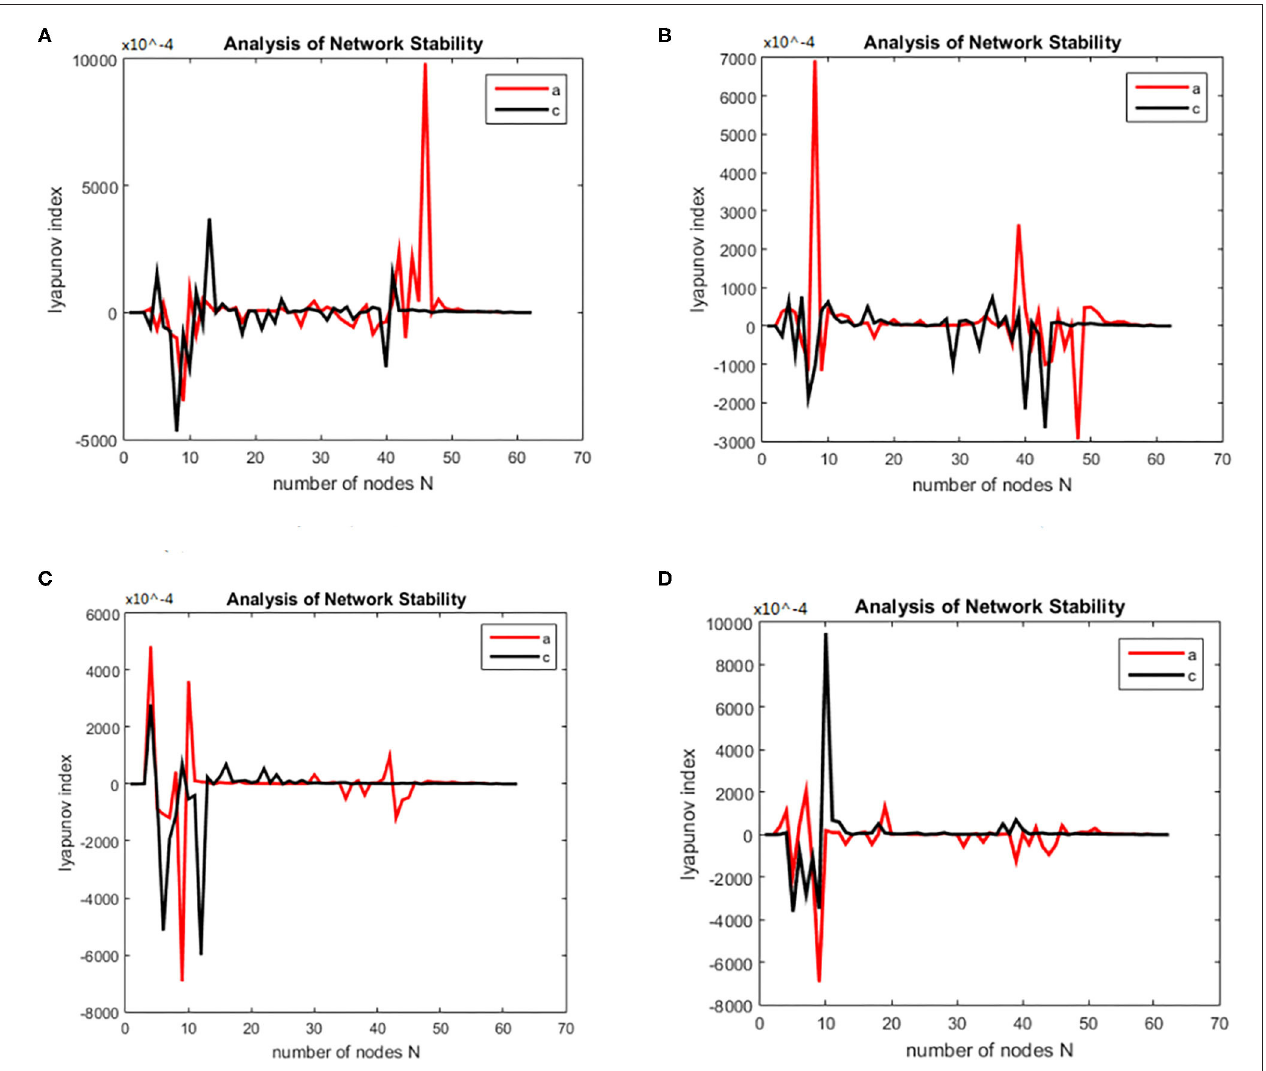
FIGURE 3 | Bain network synchronization experimental results for the same subject in the alcoholic data set under different connection densities. (A) Connection density 30%, (B) connection density 32%, (C) connection density 34%, (D) connection density